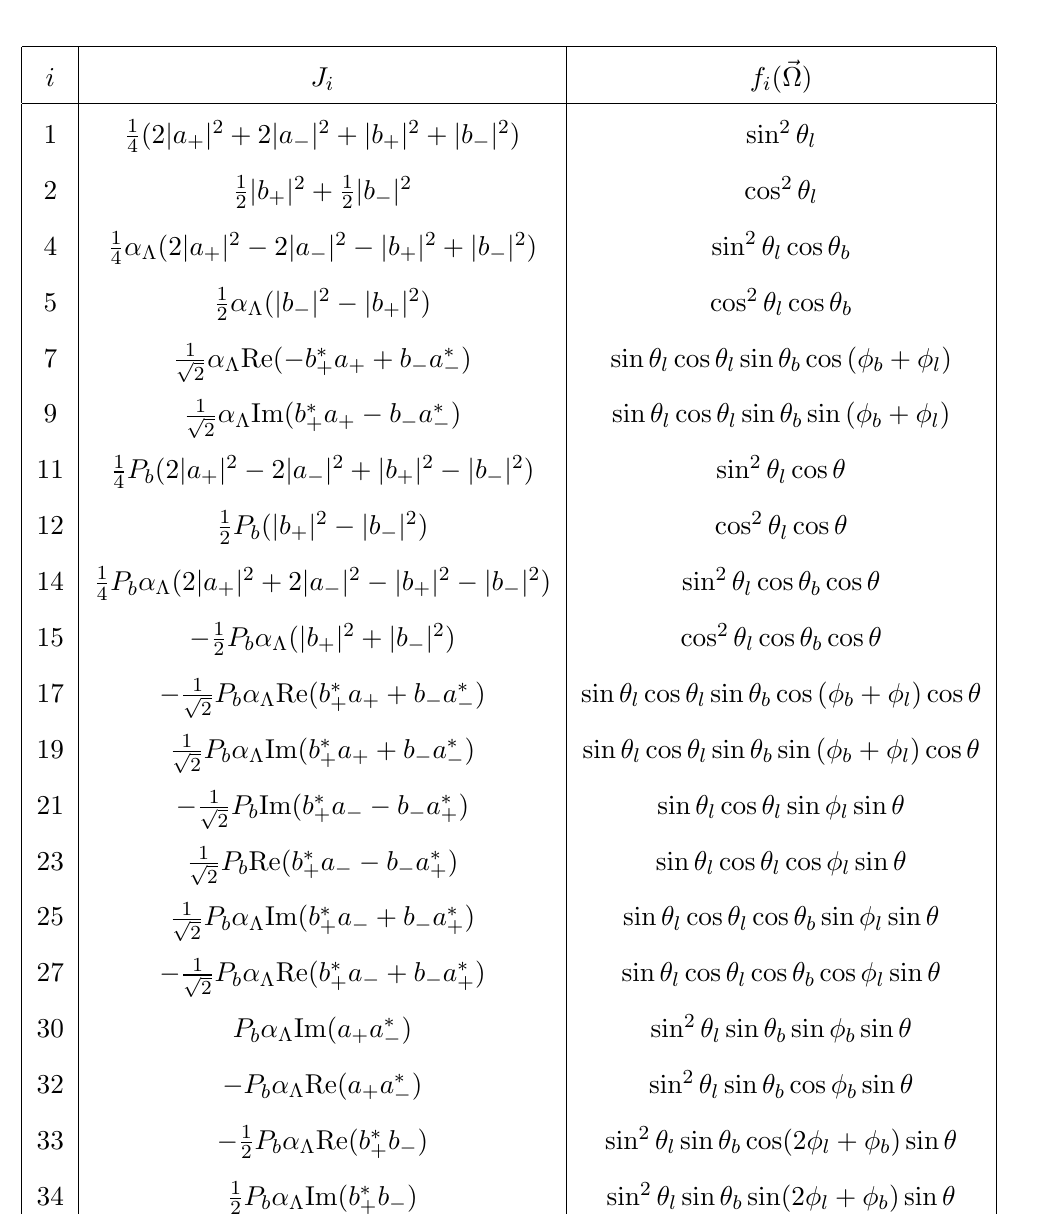
Table 1 . Angular functions parameterising the (cid:3) 0 scheme is the same as in ref.